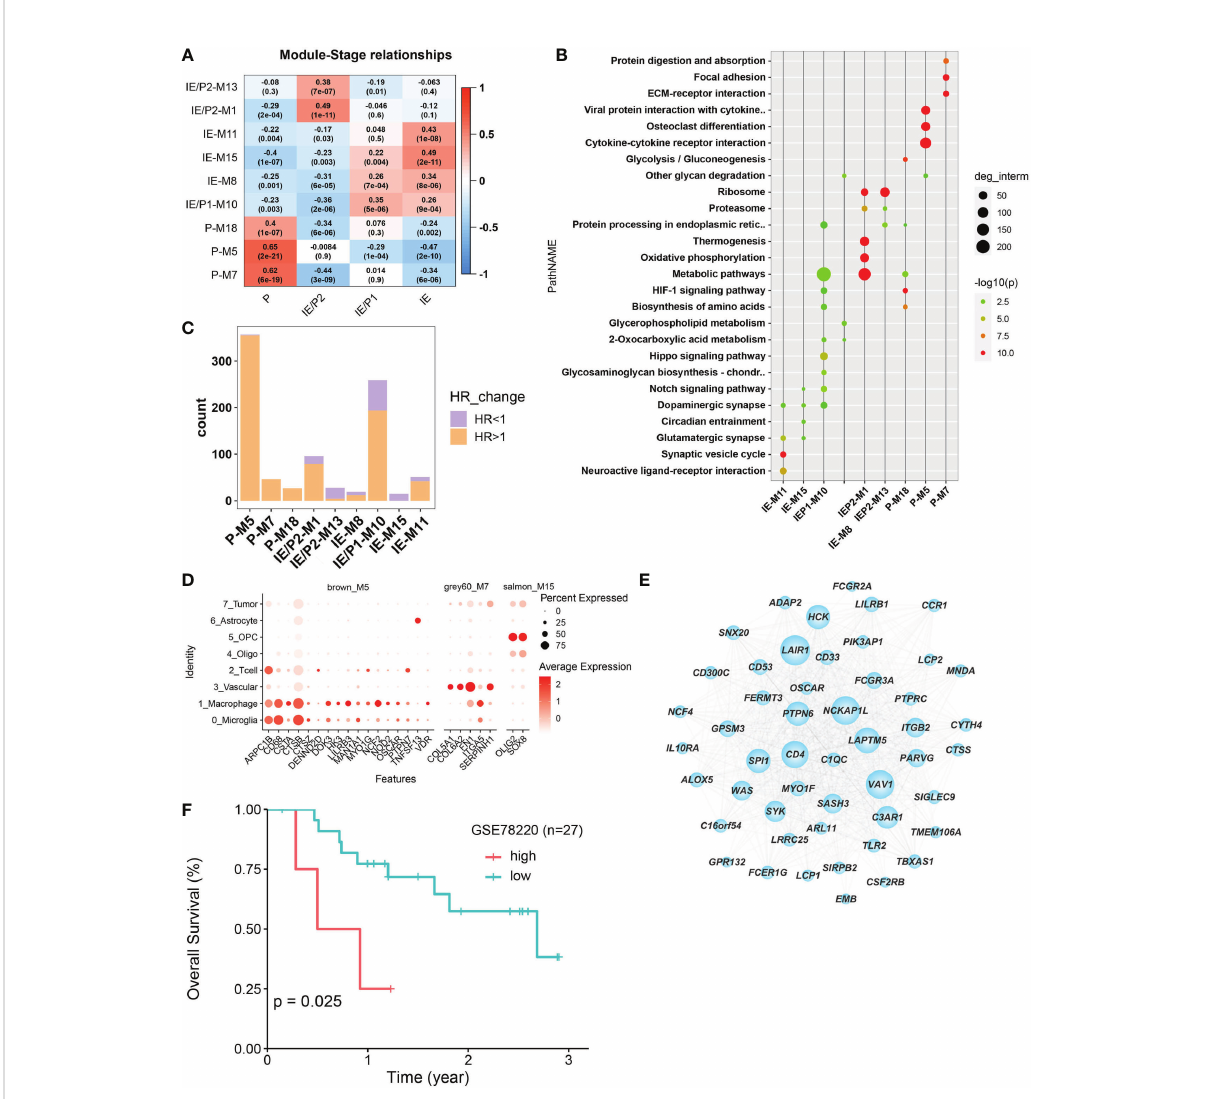
FIGURE 3 Co-expressed gene module detection by WGCNA. (A) Correlation between module eigengenes (1st principal component of modules) and TME subtypes in the TCGA – BGM cohort. The correlations were shown as a heatmap, gradually colored lower in blue and higher in red according to the Pearson correlation coef fi cient. The fi rst line of the value in the heatmap represents the correlation coef fi cient, and the second line is the p- value from the correlation test. (B) Dotplot of the top enriched pathways of each module. Dots were colored gradually by − log10 (p-value), and the size of the dots gradually changed according to the number of genes contained, with the larger the value, the larger the dots. (C) Barplot shows the number of molecules that met the requirements of univariate Cox regression p-value <0.05 in each module. Bars were colored with an HR ratio >1 (orange) or <1 (purple). (D) The distribution of expression levels of each module ’ s survival-related hub genes across different cell types. The larger the size, the larger the percent of expression. (E) Co-expression network between the top 50 hub genes selected according to the kME score. The larger in node size the higher in node degree. The top 15 genes in degree were more important and were de fi ned as Top15_hub. (F) Relationship between Top15_hub gene expression and prognosis of immunotherapy samples. The Kaplan – Meier curves comparing Top15_hub gene low and high expressed patients in an immunotherapy dataset